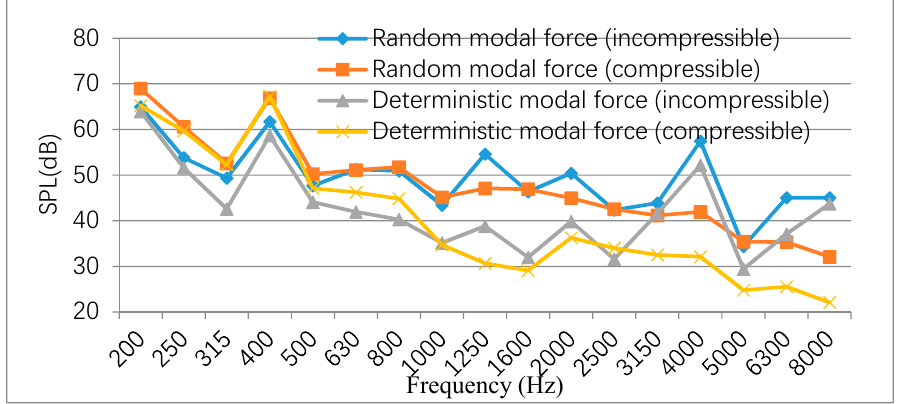
Figure 27. Comparison of the results of the random modal force and deterministic modal force under the incompressible and compressible numerical simulations.